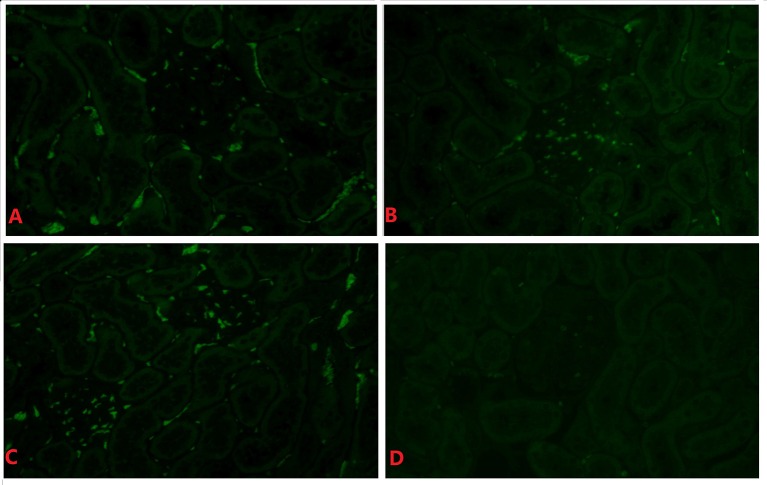
RSV F protein in renal tissue of the day 14 subgroup (indirect immunofluorescence, × 400). Positive hybridization signals appeared in the glomeruli and tubules of the RSV infection group in (A–C). There was little positive expression of RSV F protein in (D). (A) The 6 × 104 PFU RSV + vehicle, day 14 subgroup (Group A3); (B) The 6 × 104 PFU RSV + 6 × 106 PFU RSV, day 14 subgroup (Group B3); (C) The 6 × 104 PFU RSV + 6 × 104 PFU RSV, day 14 subgroup (Group C3); (D) Vehicle + vehicle group, day 14 subgroup (Group D3).